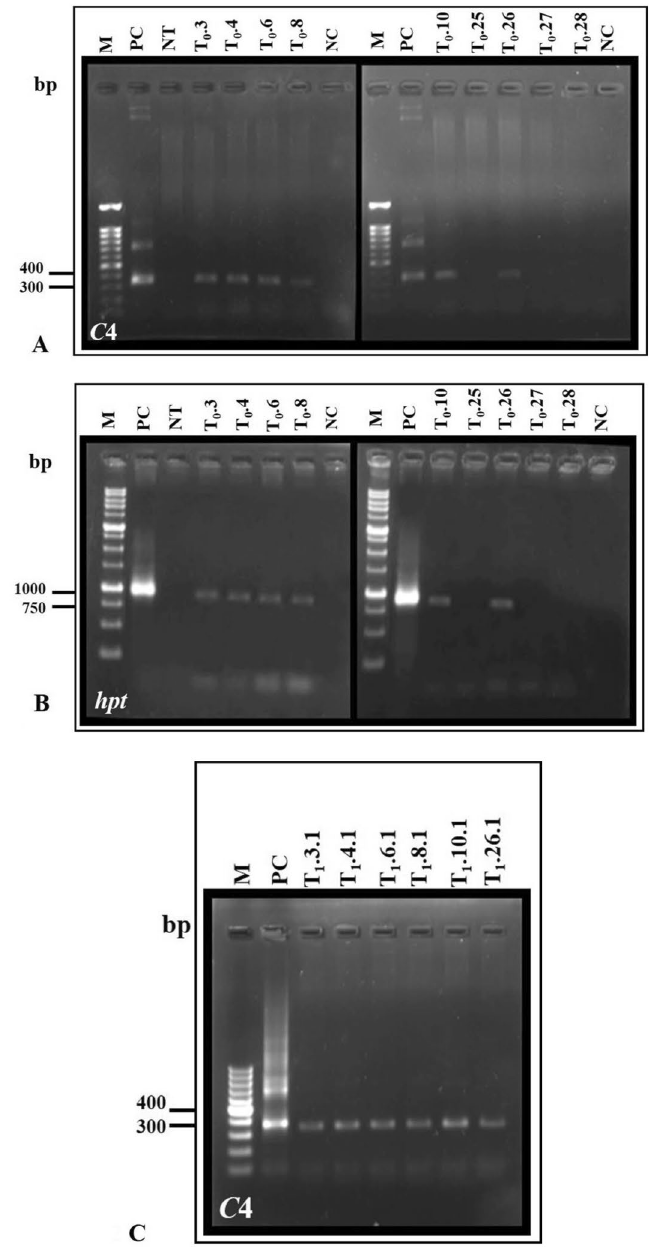
Figure 2. PCR amplification of: ( A ) silencing suppressor Cotton leaf curl Multan virus CLCuMuV- C4 gene, ( B ) hygromycin phosphotransferase ( hpt ) gene in transformed T 0 G. hirsutum cv. HS6 plants. T 0 .3, T 0 .4, T 0 .6, T 0 .8, T 0 .10 and T 0 .26 denote PCR positive lines, while T 0 .25, T 0 .27 T 0 .28 were found PCR negative. M is 100 bp DNA marker, PC is positive control, NT is non-transformed control and NC is negative controls. ( C ) CLCuMuV- C4 gene in T 1 G. hirsutum cv. HS6- T 1 .3, T 1 .4, T 1 .6, T 1 .8, T 1 .10 and T 1 .26 lines employing C4 gene specific primers. M is100 bp DNA marker, In PC, construct plasmid DNA served as the template; In NC/NT, genomic DNA from non-transformed control was employed as the template in